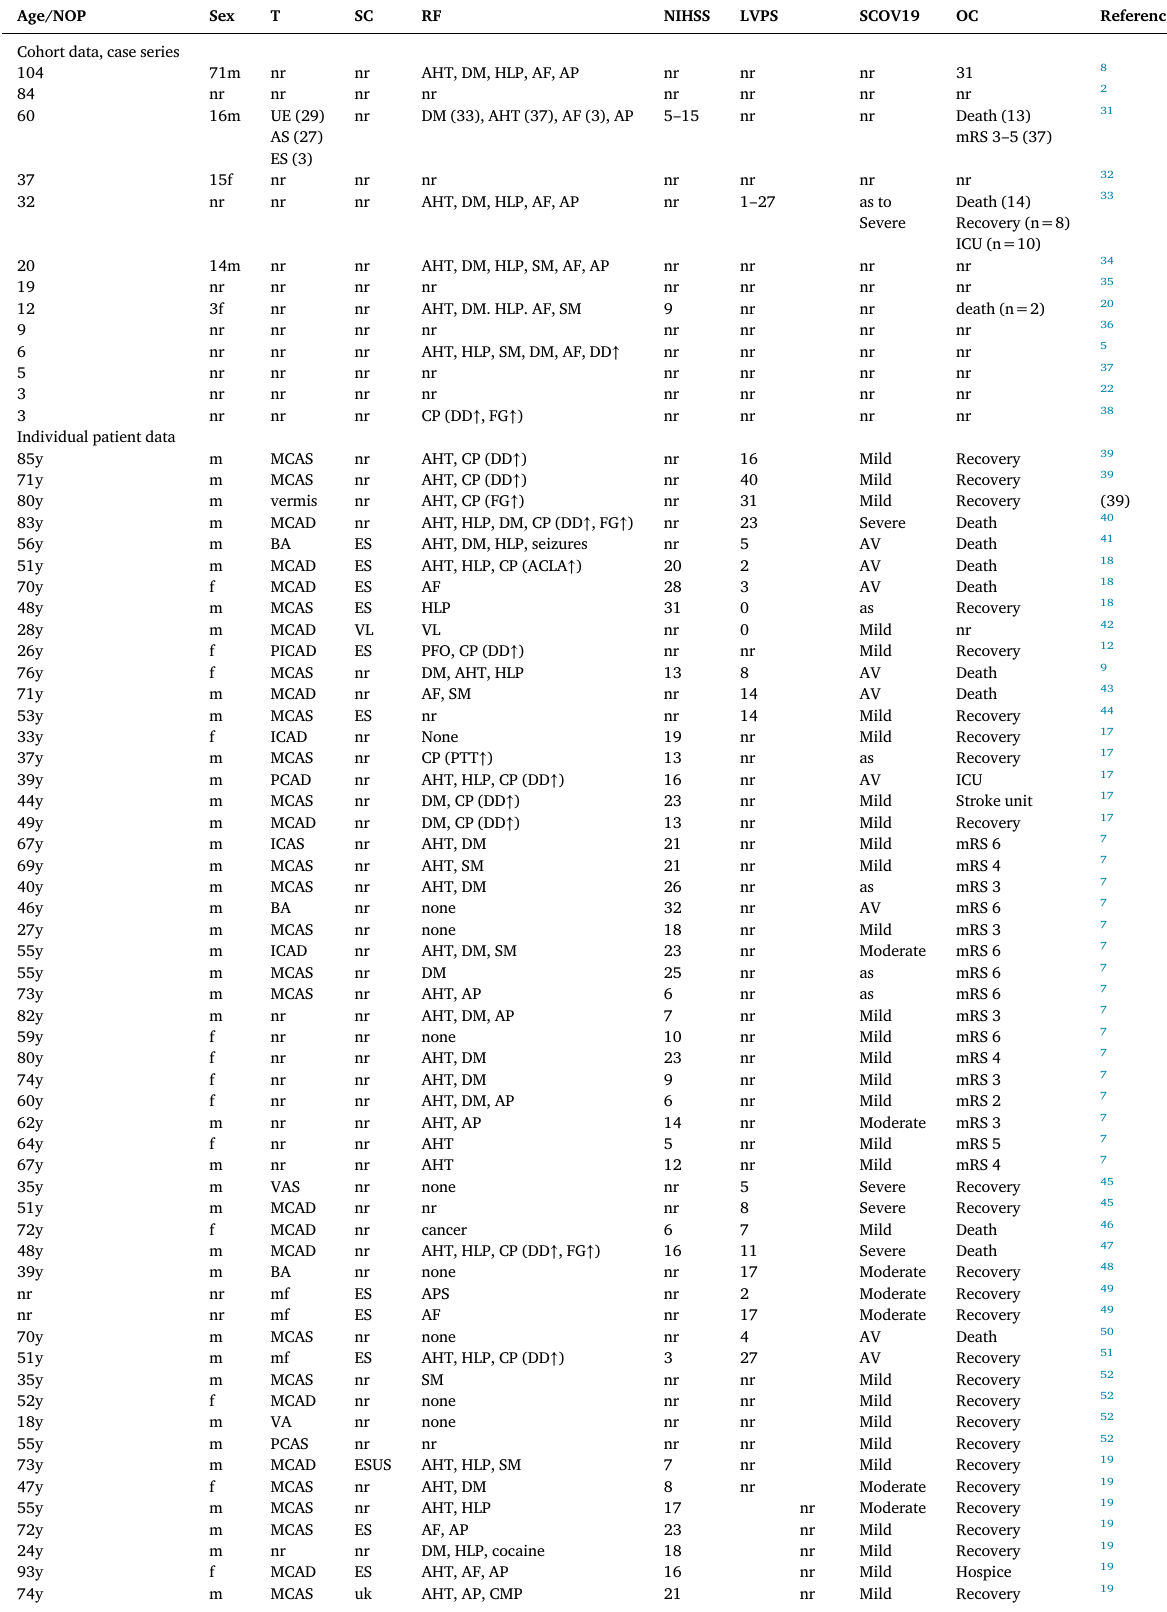
Table 1 Patients with a COVID-stroke reported in the literature in September and October 2020 (meta-analyses were excluded).